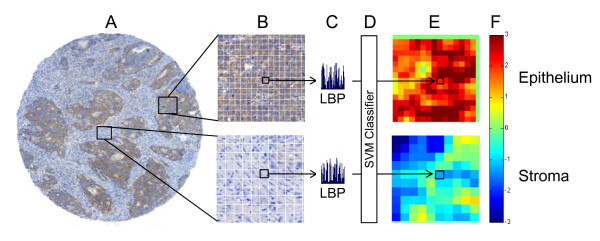
Principle of image annotation, block-based feature extraction and classification. Areas representative of pure tumor epithelium and stroma were identified in the digitized tissue microarray spots (A) and then split into blocks of size 80 × 80 pixels (B). A local binary pattern (LBP/C) operator was applied to the blocks and block-specific LBP histograms generated (C). The block histograms are then used as input to a support vector machine (SVM) classifier (D), which assigns a tissue category (epithelium or stroma) score to the block. The SVM score for each block is pseudo colored to visualize the output (E), and the average block score is taken to represent the predicted class of an image (F)